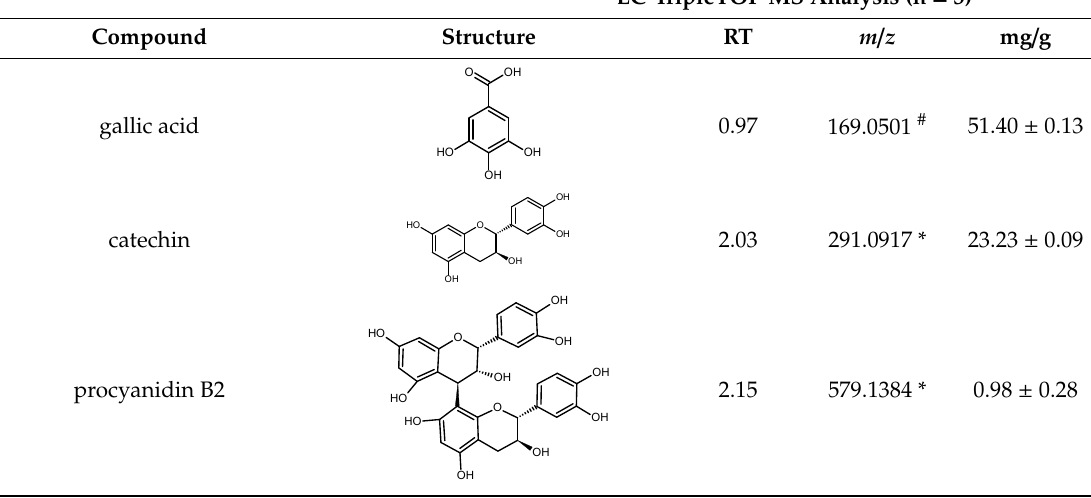
Table 2. Quantitative identification of particular compounds in defatted evening primrose seeds extract determined by LC-TripleTOF 5600 + -MS based on chromatograms present in Figure S3 in Supplementary Information; RT-retention time, m / z -mass to ion ratio of compounds in negative (#) and positive (*) ionization mode of TOF 5600 + -MS, mg / g-quantitative analysis of phenolic compounds according to standard curves.